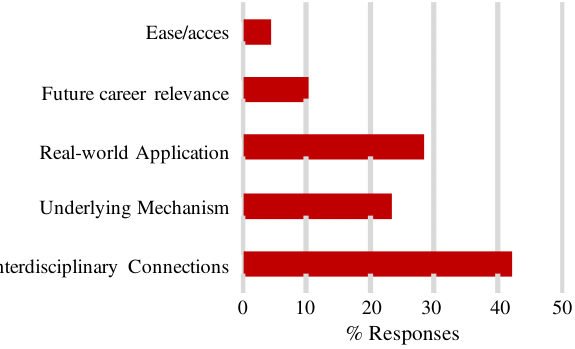
FIG. 3. The percentages of “ rich and nuanced positive student responses ” coded into each of the five categories of Table III are displayed. Data are shown for the IPLS course (years 1 – 4, N ¼ 175